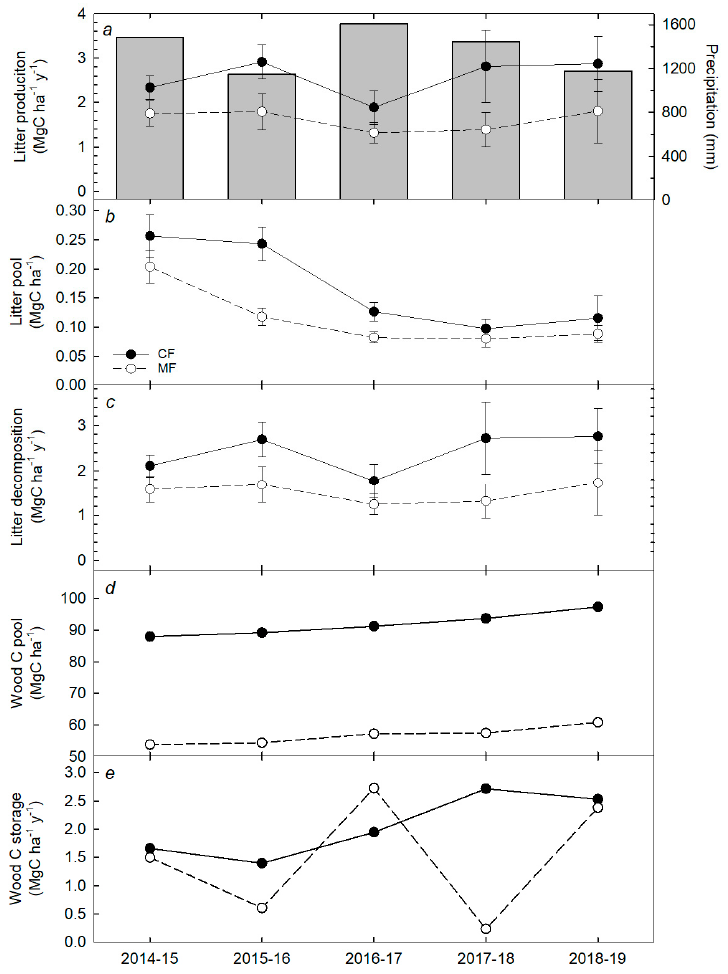
Figure 4. Mean ( ± 95% confidence interval; n = 6) annual litter production and precipitation ( a ), litter pool mass ( b ), decomposition rate ( c ), and total aboveground wood C pool size ( d ) and aboveground wood C storage ( e ) for the seasonally flooded cerrado forest (CF: closed symbols, solid lines) and the upland mixed forest (MF: open symbols, dashed lines) during the 2014–19 study period.